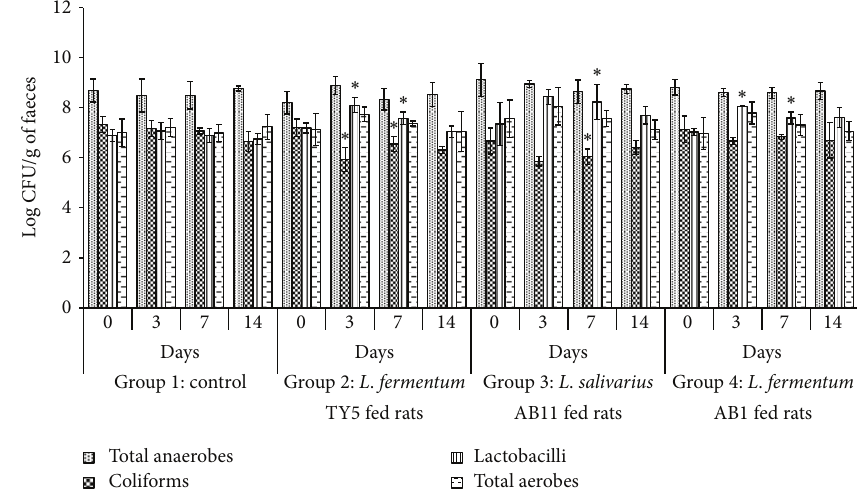
Figure 3: Analysis of faecal microbiota composition in rats before and after oral administration of selected Lactobacillus . Each rat administered ∼ 10 8 cells/day for one week. Viable counts of total anaerobes, coliforms, lactobacilli, and total aerobes expressed in terms of log CFU/g of faeces on days 0, 3, 7, and 14. Each value was represented as mean ± SD of log CFU/g wet faeces ( 𝑛 = four rats per group). ∗ Significant difference in viable counts.